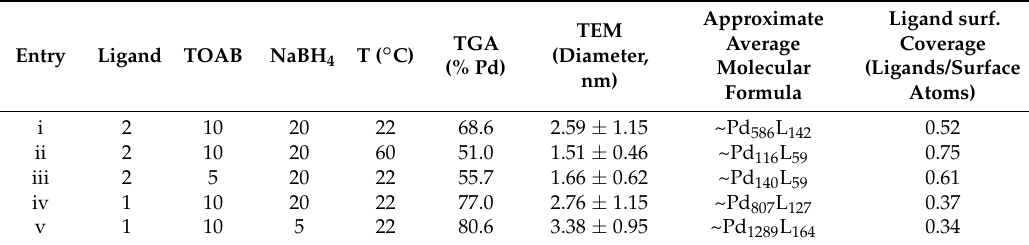
Table 3. Different Synthetic Conditions and Characterization of Various PdNPs. The molar equivalent of each reaction species corresponds to one equivalent of Pd precursor. Data reproduced from Ref. [59],